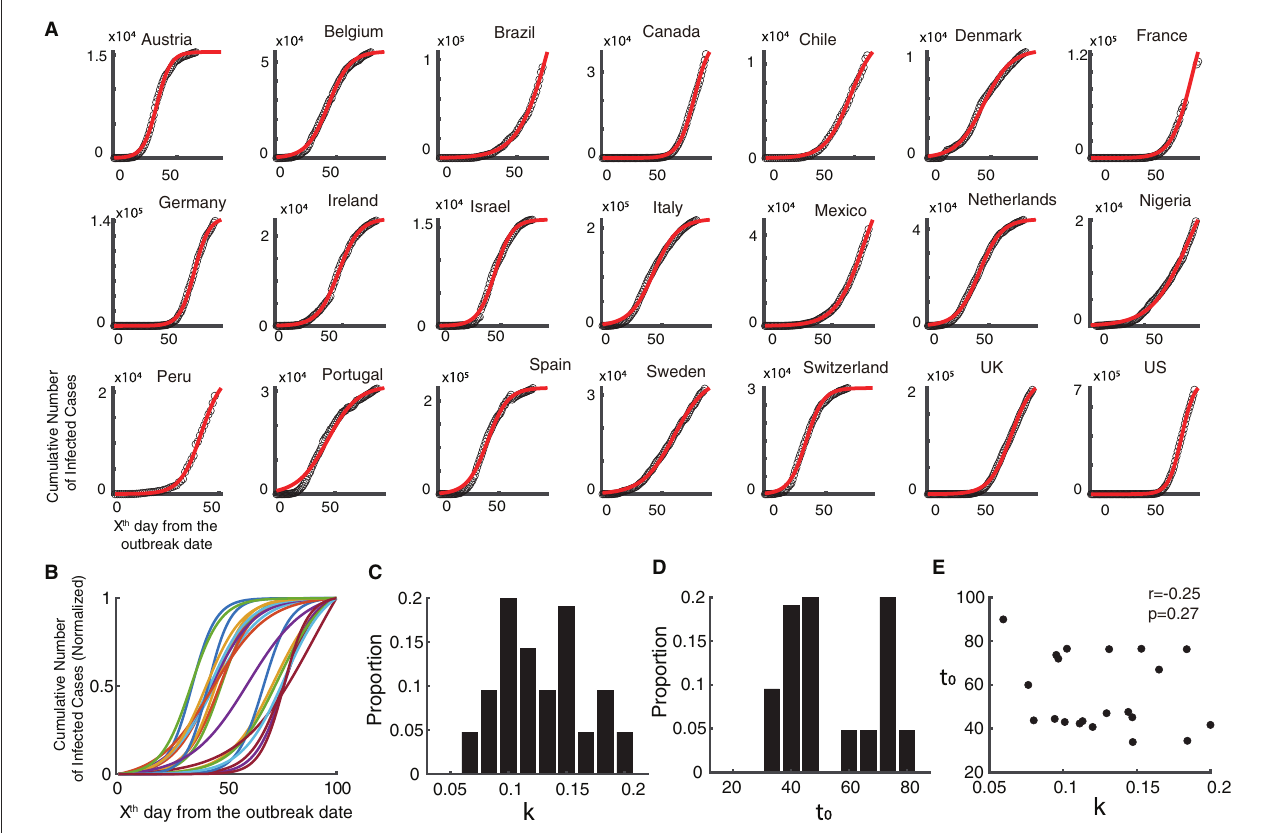
FIGURE3 Temporal dynamics of the COVID-19 epidemic in 2020. (A) Raw data of the cumulative infected cases of COVID-19 is shown in black dots and the fitted curve of the model is shown in red, in 2020 (initial stage of the epidemic). (B) Normalized fitted curves of model for 21 countries. (C) Distribution of growth rate (k). (D) Distribution of semi-saturation period (t 0 ). (E) Relationship between growth rate (k) and semi-saturation period (t 0